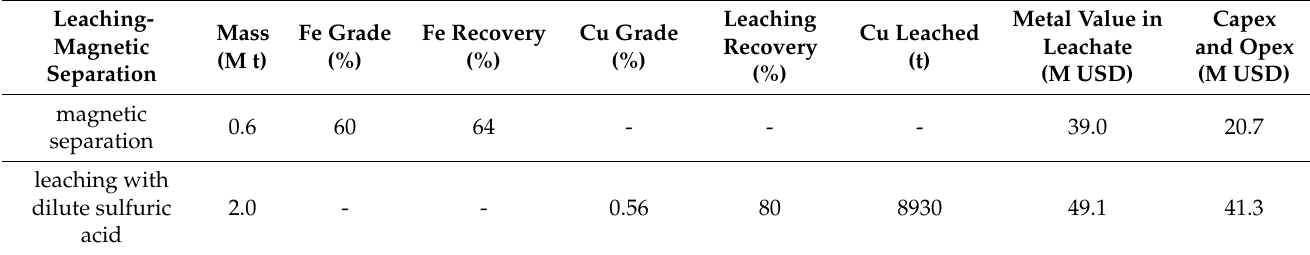
Table 11. Combination of magnetic separation and leaching, which has given the best economic results in the processing tests. Leaching recoveries taken from processing tests. Data from magnetic separation is theoretical, as larger scale processing tests are still to